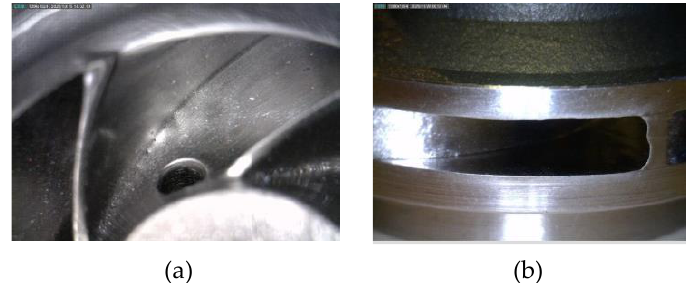
Figure 10. Details of Impeller 2 (after media change) showing ( a ) interior surface and ( b ) pressure side.